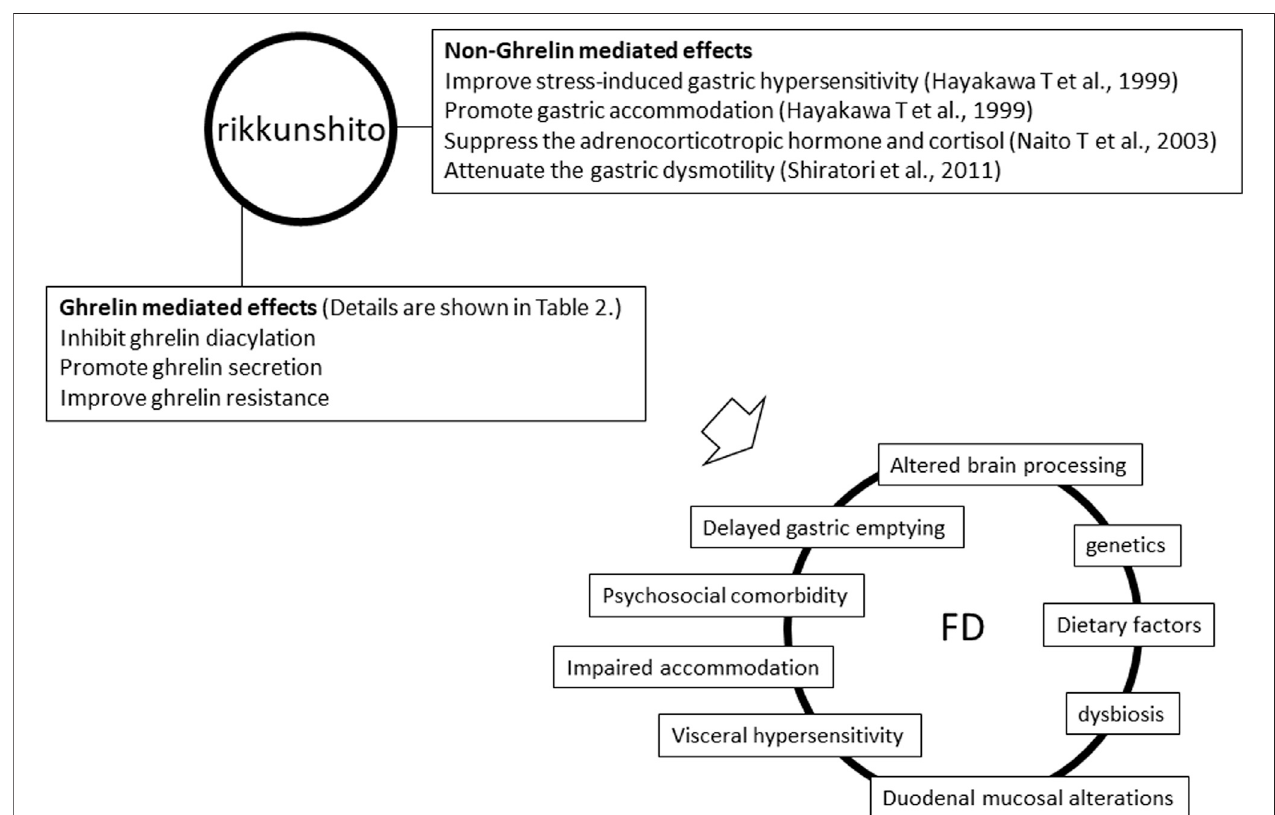
FIGURE 1 | Multiple effects of rikkunshito and multiple pathophysiologies of functional dyspepsia.